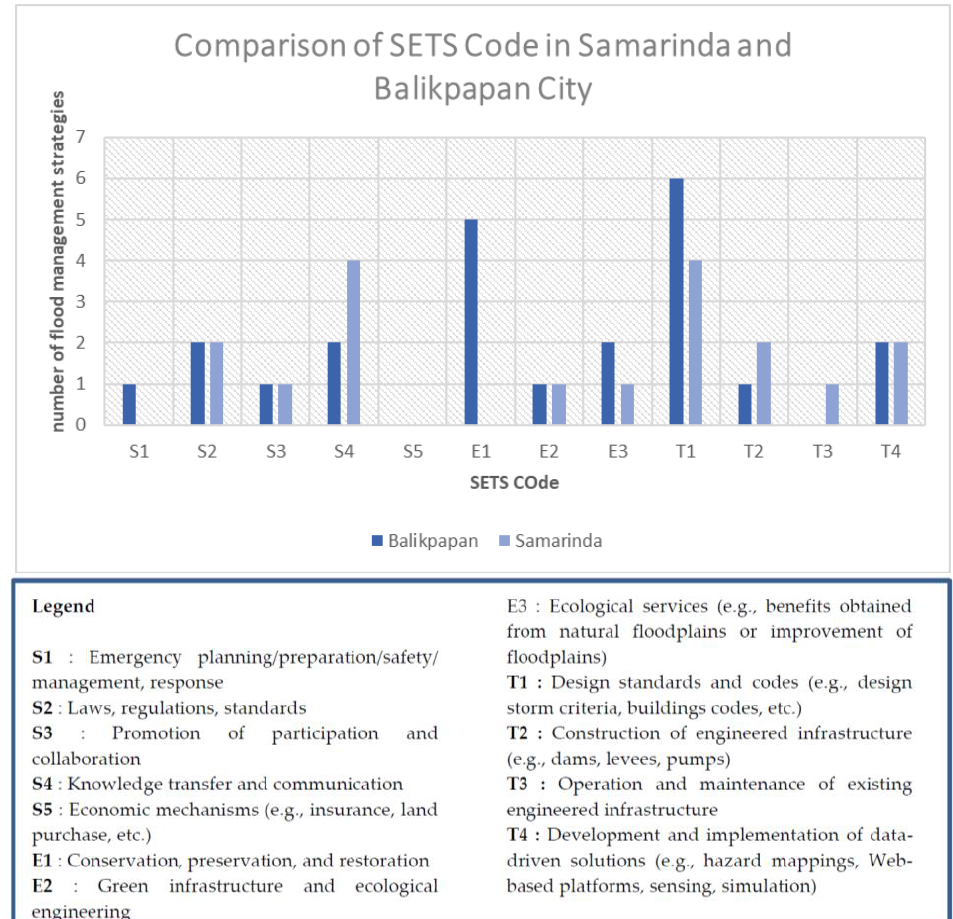
Figure 2. Distribution of the SETS dimensions in Balikpapan and Samarinda (Source: authors).